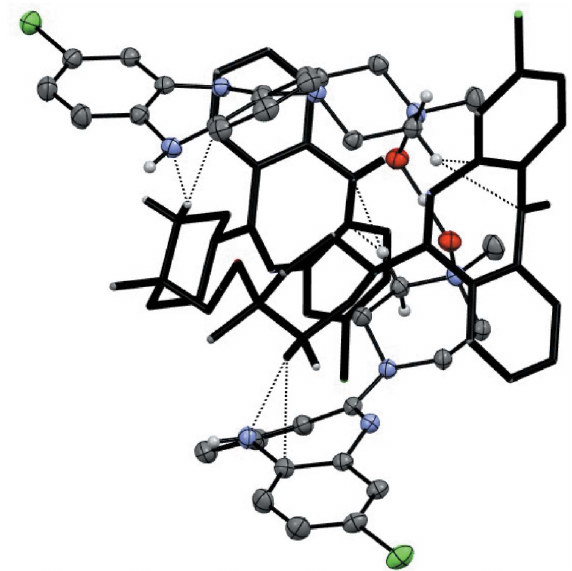
Figure 5 C—H (cid:2)(cid:2)(cid:2) N and C—H (cid:2)(cid:2)(cid:2) (cid:2) interactions at the interface of neighbouring tetrameric (CNO) 4 (cid:2) (HCl) rings in the poly[ n